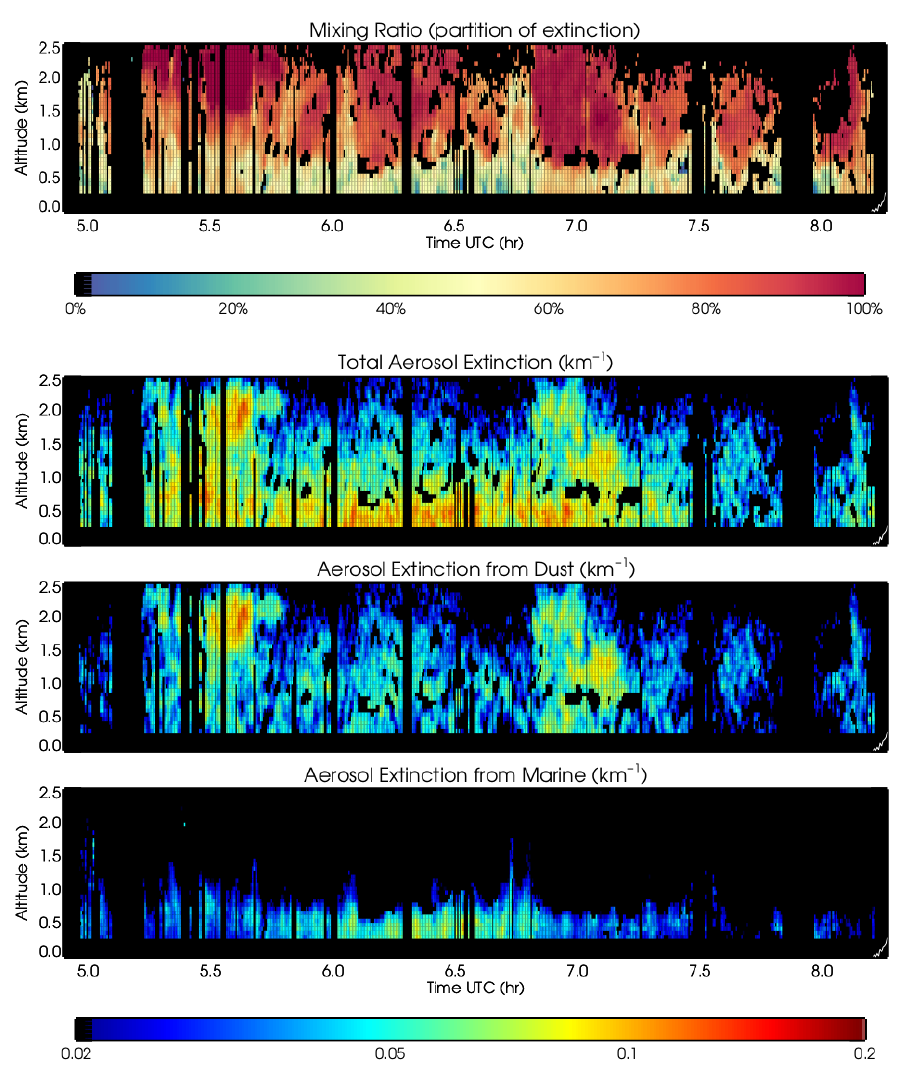
Fig. 8. Top panel illustrates the extinction mixing ratio (percentage of 532nm extinction due to dust) for the mixtures of marine aerosol and transported Saharan dust observed by HSRL-1 on 22 August 2010 in the Caribbean Sea. The extinction mixing ratio is inferred from the lidar measurements and Eqs. (30)–(32) as described in the text. In this case, blue colors indicate more marine aerosol and red indicates more dust. Bottom three panels show aerosol extinction measurements and aerosol extinction apportioned to the dust and marine components